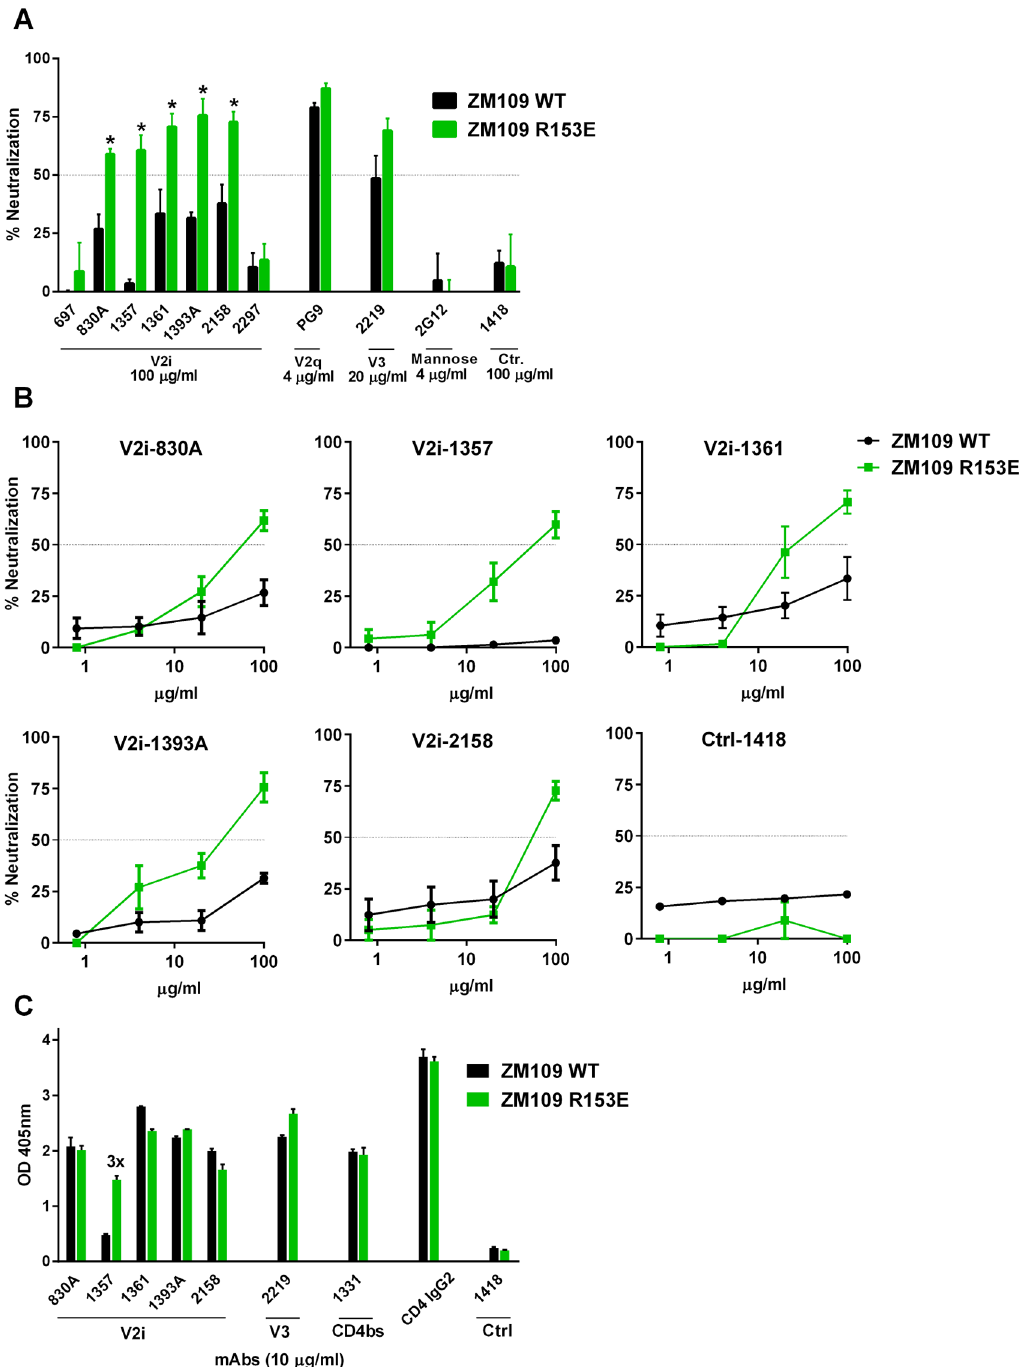
Fig 3. A charge change at position 153 in the V1 region of ZM109 increases the virus sensitivity to most V2i mAbs. (A) Neutralization of ZM109 WT and R153E mutant pseudoviruses by V2i and other mAbs. * , p < 0.05 based on a two-way ANOVA test of the mAb titration results. (B) Titration curves showing differences in sensitivity of ZM109 WT vs. R153E to neutralization by five of the seven V2i mAbs. Statistical analyses were performed for neutralization data reaching above 50%. (C) ELISA reactivity of mAbs and CD4-IgG2 to gp120s from virus lysates of ZM109 WT and R153E.